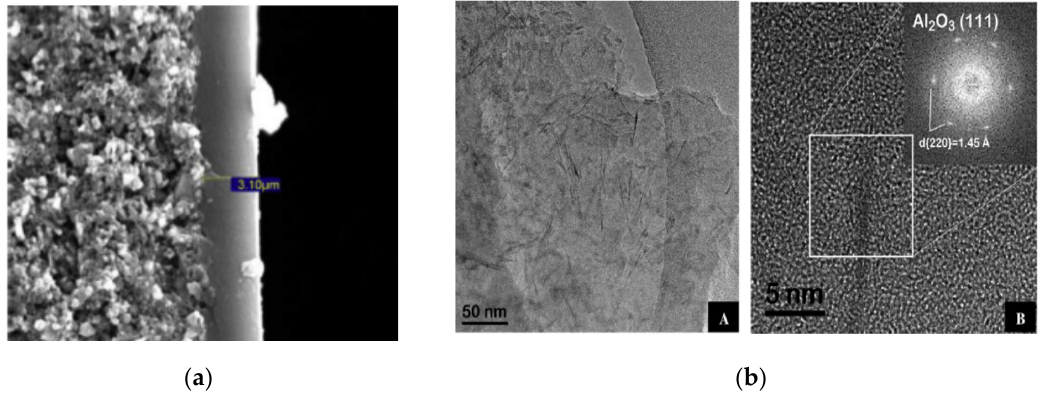
Figure 1. Alumina‐composite‐CMSM: ( a ) SEM picture showing the selective layer on the porous alumina support. Reproduced with permission from [51], Elsevier, 2014; ( b ) HRTEM pictures of the composite‐unsupported membrane, the inset depicts digital diffractogram of the Al 2 O 3 nanoparticles. Reproduced with permission from [40], Carbon, 2011.